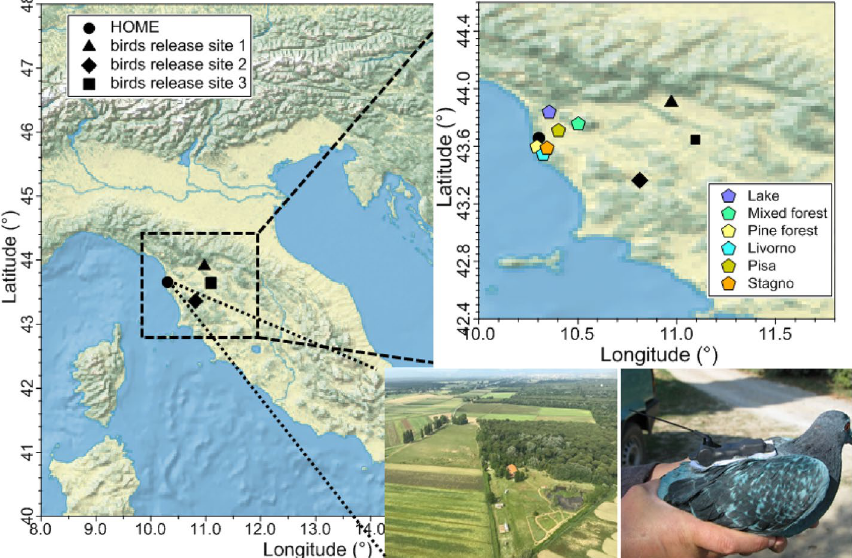
Figure 1. Map of the sampling area. The point designated as “home” refers to the birds aviary of Arnino (43°39 ′ 25.7 ″ N 10°18 ′ 14.7 ″ E) located in Tuscany in the area of Pisa-Livorno. Points on the map show the three sites used for releasing birds during a navigational experiment and the main biogenic and anthropogenic sites in the area. Photos show an aerial view of the Arnino field site during the airborne sampling (left) and a homing pigeon equipped with a GPS-tag before being released for testing its homing performance (right). Figure drawn with Igor